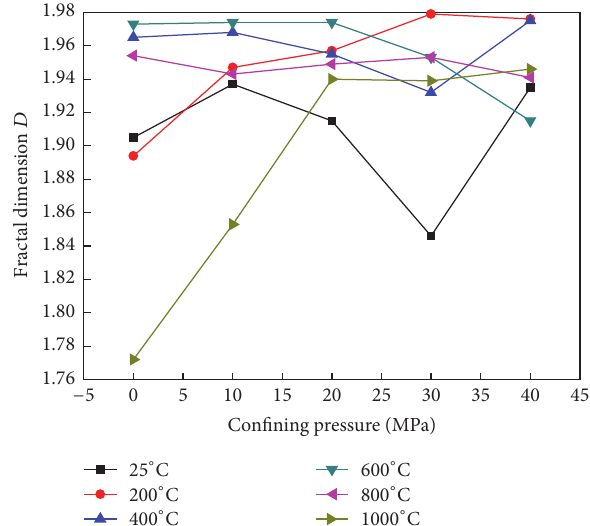
Figure 6: Relationship between fractal dimension and confining pressure under temperature at all